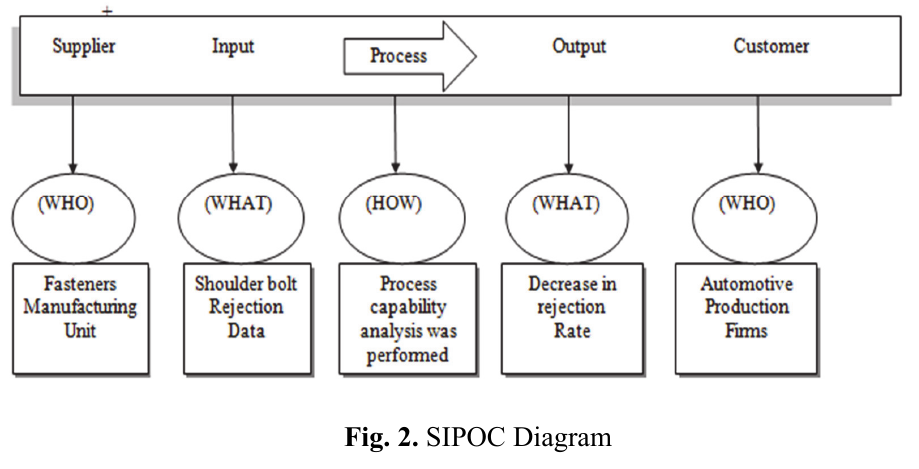
Fig. 2. SIPOC Diagram